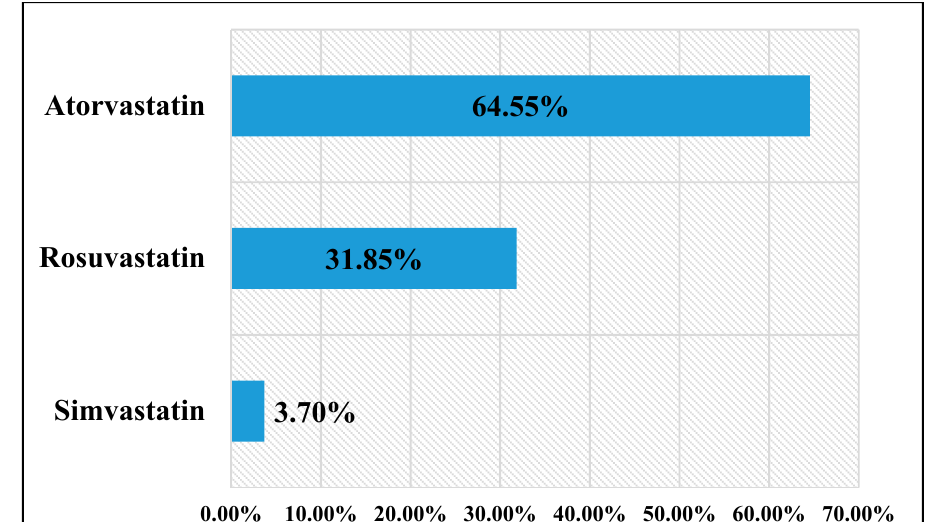
Figure 1. Types of statins administered in our study group.